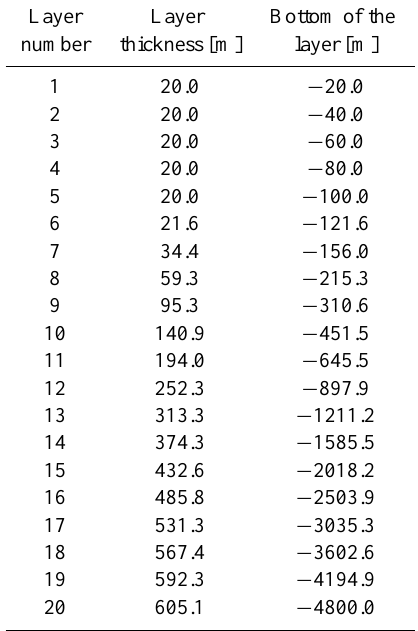
Table 1. Vertical grid spacing of the